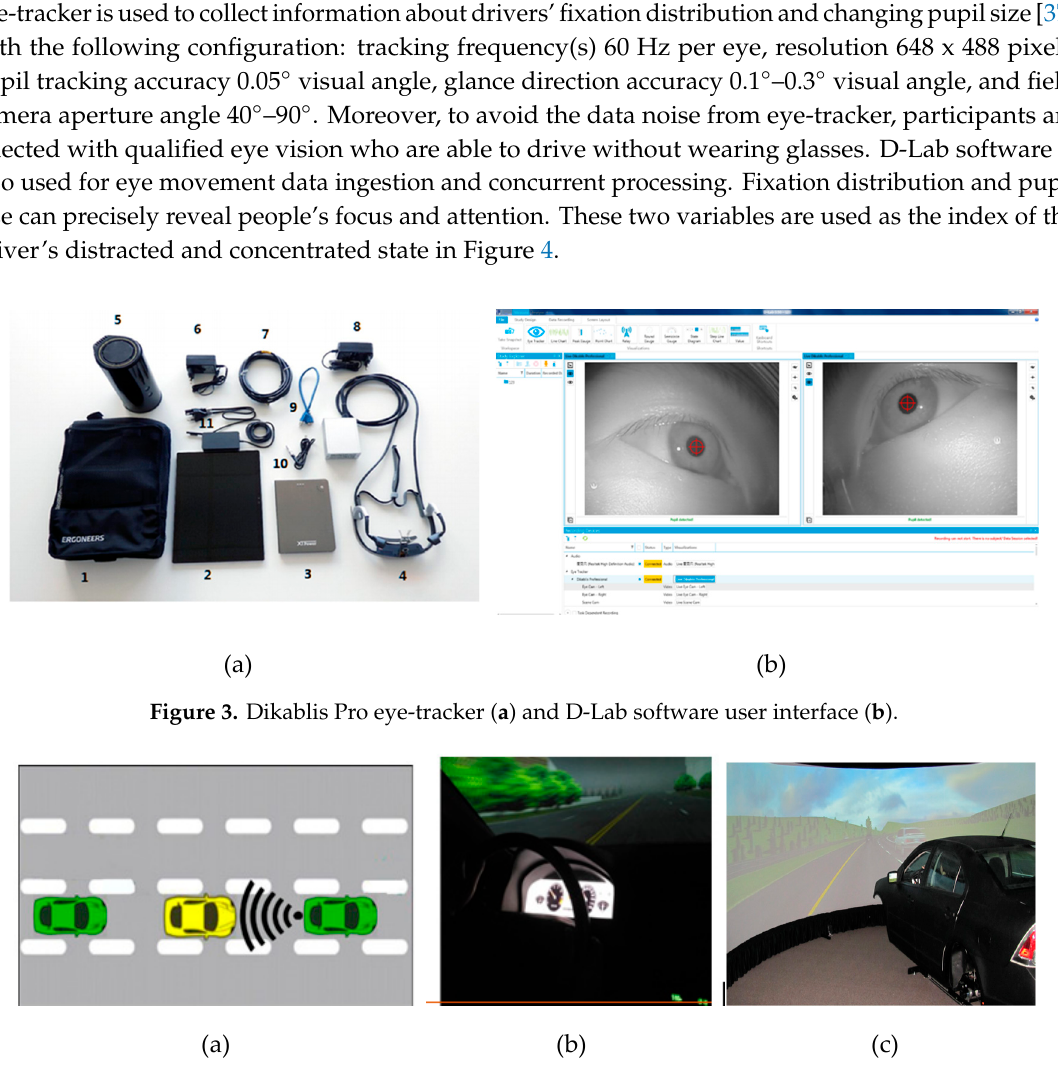
Figure 4. Driving simulator experiment with Wi-Fi Direct ( a ) inside view ( b ) and outside view ( c ).